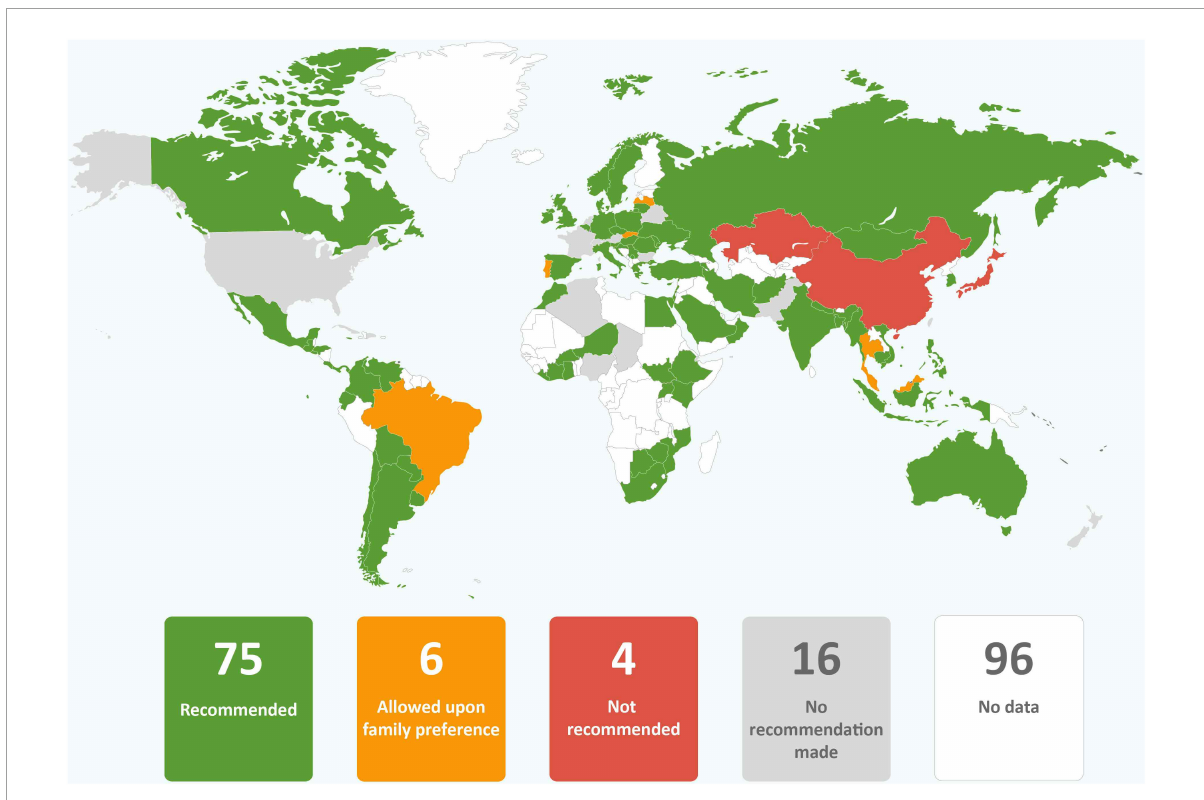
FIGURE9 Global distribution of recommendations on the provision of expressed breastmilk to infants of mothers with COVID-19 unable to directly breastfeed (data from 101